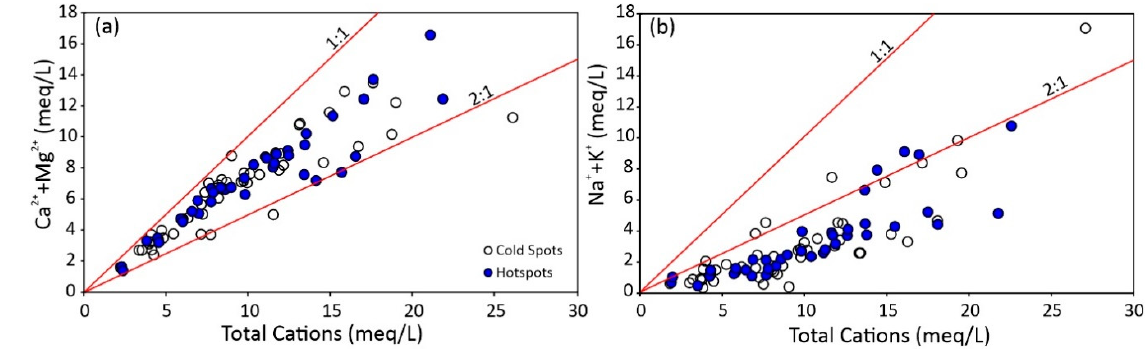
Figure 3. Piper trilinear diagram classifying major hydrogeochemical facies of groundwater in the Yan Oya river basin.